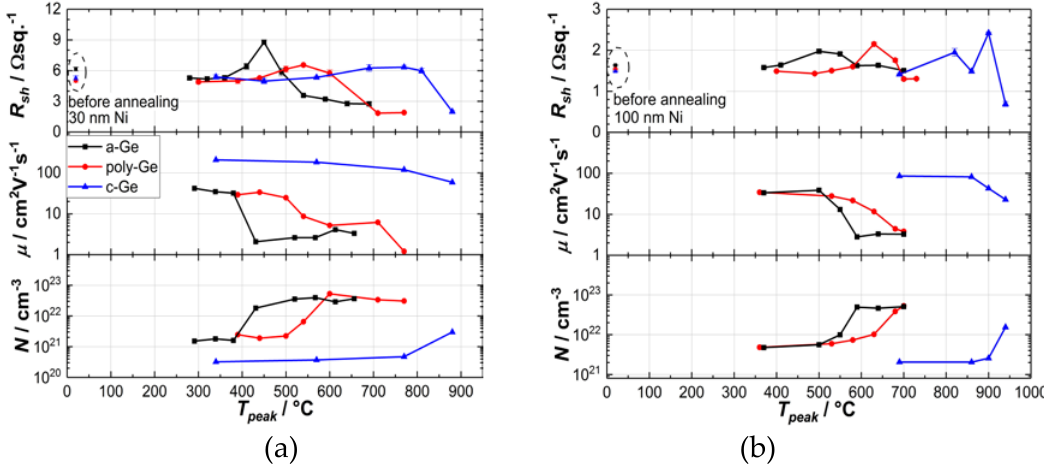
Figure 1. Electrical characterization of annealed Ni/Ge structures for ( a ) 30 nm Ni and ( b ) 100 nm Ni as a function of T peak . Sheet resistance, mobility and charge carrier density were estimated by four-point-probe and Hall measurements. The carrier concentration was obtained by multiplying the 2D carrier concentration by the effective thickness of the initial Ni/Ge layer system or its equivalent in case of c-Ge.